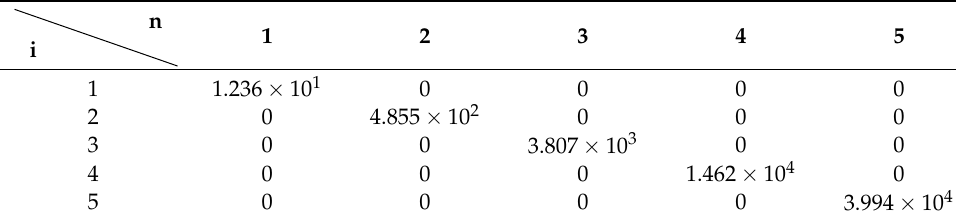
(cid:82) 1 φ n φ iv d ξ . i 0